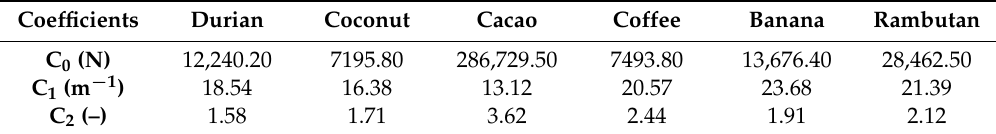
Table 9. Coefficients of tangent curve model stated for investigated bio-briquette